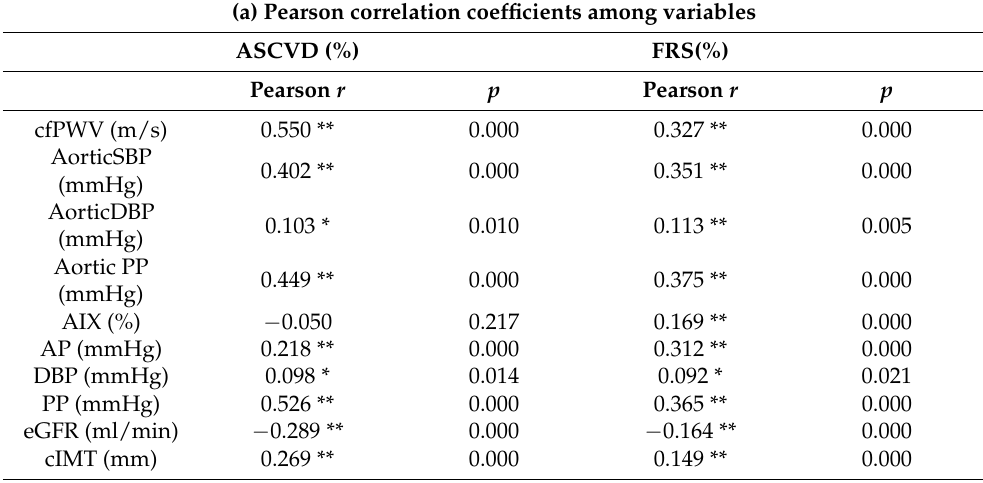
Table 2. (a) Pearson correlation coefficients among variables; (b) Pearson correlation coefficients between cfPWV correlate with variables.